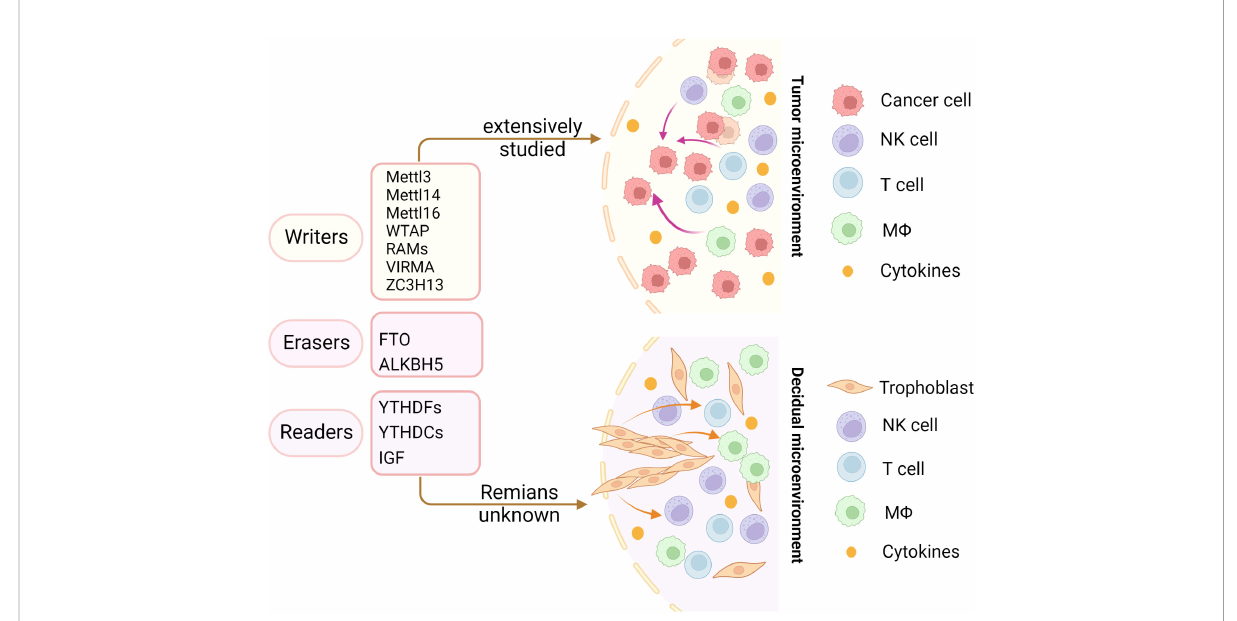
FIGURE 8 Insights into m6A modi fi cation in the tumor and decidual microenvironment. The m6A modi fi cations in the tumor immune microenvironment have been extensively studied. However, the role of m6A modi fi cations in decidual immune cells remains largely unknown. The same immune trajectory of decidual and tumor immune microenvironments encouraged us to study the mechanisms of m6A in decidual immune